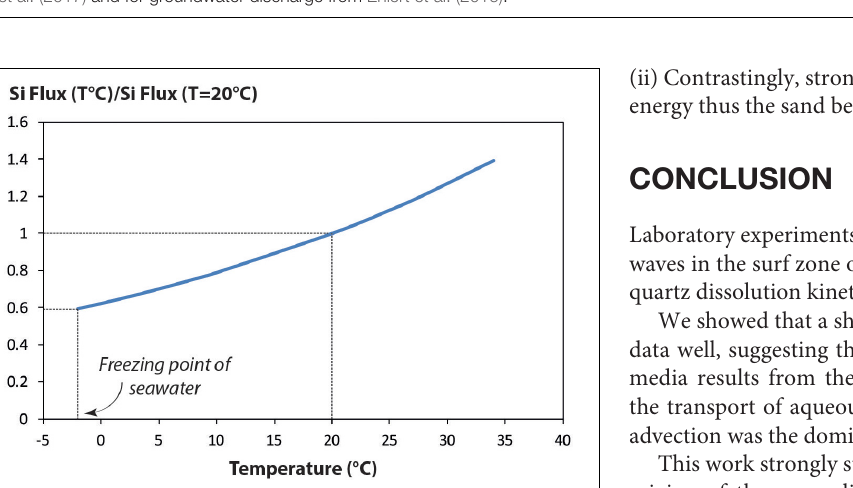
FIGURE 5 | Revised sources and sinks of the global oceanic Si cycle. Inspired by Tréguer and De La Rocha (2013). Values for reverse weathering are from Rahman et al. (2017) and for groundwater discharge from Ehlert et al. (2016).